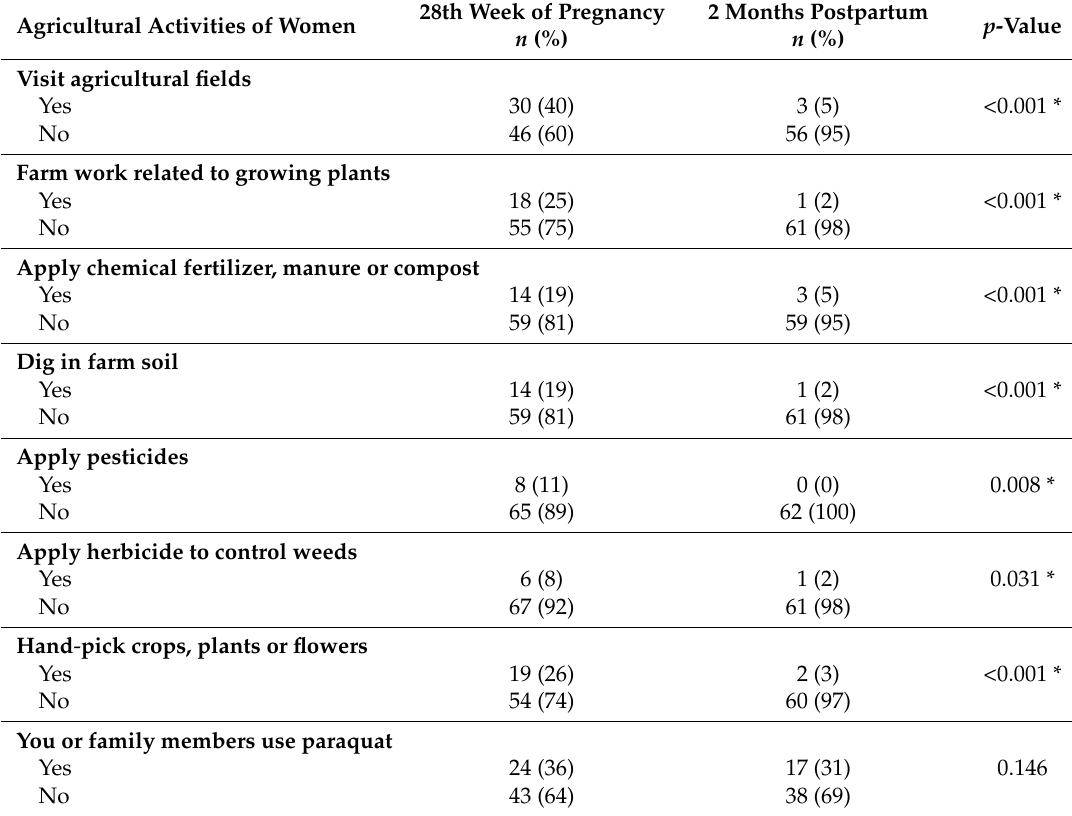
Table 2. Agricultural activities of women at 28 weeks of pregnancy and 2 months